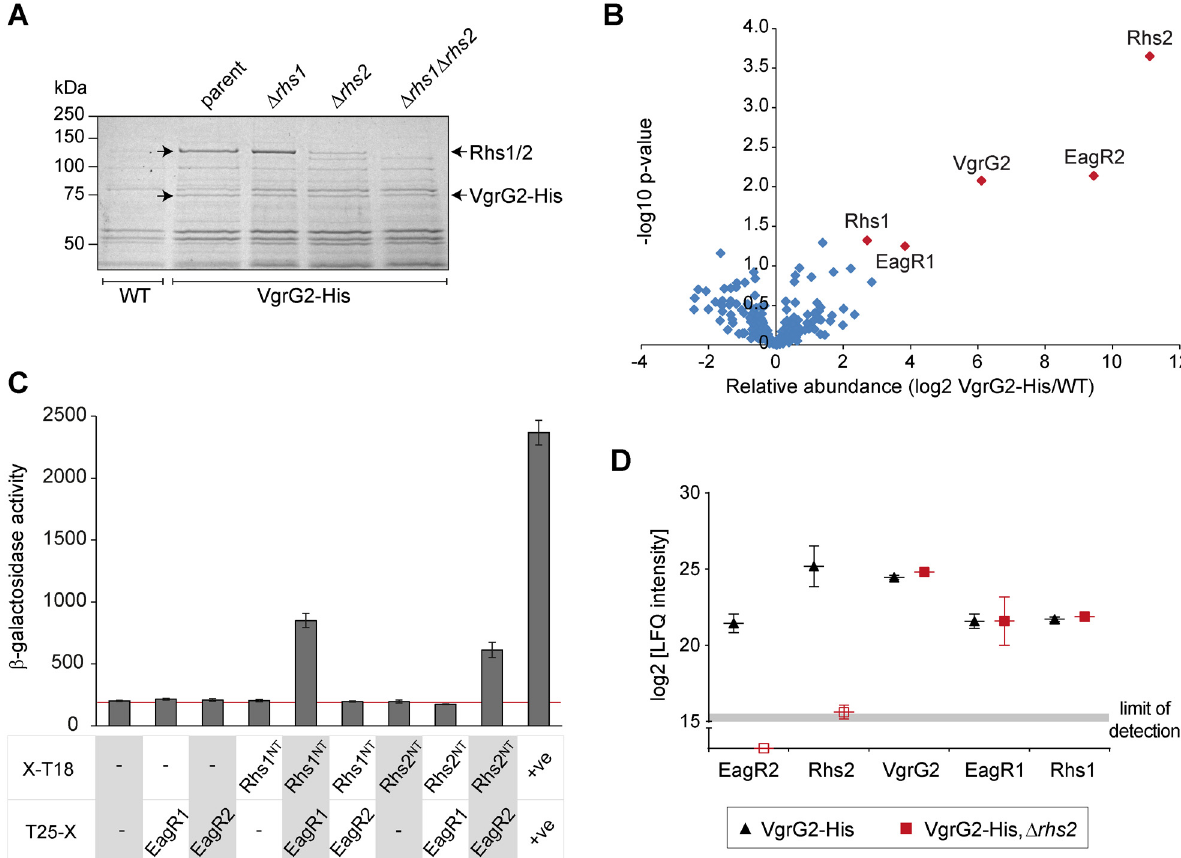
Fig 7. Isolation of native VgrG and PAAR containing complexes. (A) Identification of VgrG2-associated proteins by small-scale affinity purification. Total cellular proteins from S . marcescens Db10 encoding the VgrG2-His 6 fusion protein, in an otherwise wild type genetic background (parental) or in strains lacking Rhs1 ( Δ rhs1 ) or Rhs2 ( Δ rhs2 ) or both Rhs proteins ( Δ rhs1 Δ rhs2 ), or from the wild type (WT, no His 6 tag) as a negative control, were incubated with Ni 2+ beads to co-isolate VgrG2-His 6 (VgrG2-His) with any bound proteins. Eluted proteins were resolved by SDS-PAGE and visualised by Coomassie staining. Arrows indicate the positions of two VgrG2-His specific bands, one corresponding to VgrG2-His (predicted MW 72 kDa) and one corresponding to a mixture, in the parental strain, of Rhs1 and Rhs2 (predicted MW 165 and 158 kDa, respectively); identifications were confirmed by mass spectrometry. (B) Quantitative analysis of the proteins present in samples isolated as above by affinity purification from the control strain (WT) or the strain carrying the VgrG2-His fusion (in an otherwise wild type background) by solution mass spectrometry. Proteins were identified as being associated with VgrG2 when significantly enriched in the VgrG2-His sample compared with the WT sample, with relative abundance in VgrG2-His/WT > 4-fold, p < 0.05 (red diamonds) (C) Bacterial two-hybrid assay to detect interactions between the N-terminal domain of Rhs1 or Rhs2, each fused with T18 (Rhs1 NT -T18, pSC699, and Rhs2 NT -T18, pSC700), and full-length EagR1 or EagR2, each fused with T25 (T25-EagR1, pSC688, and T25-EagR2, pSC689). Negative controls were provided by the empty vectors, pUT18 and pT25 (-), and a positive control by the self-interaction of TssK (+ve; TssK-T18, pSC048, and T25-TssK, pSC053). Shown is β -galactosidase activity, expressed as Δ 405/ min/ml/OD 600 , of the reporter strain transformed with the combinations of plasmids indicated. Bars show mean +/- SEM (n = 3 independent transformations) and the background level of activity is indicated by a red line. (D) As for part B, except that the VgrG2-His affinity purification was performed in the parental and Δ rhs2 backgrounds. The abundance of each of the VgrG2-associated proteins identified in part B in the two strains is given (represented as the log2 of the label-free quantitation intensities), with the effective limit of detection indicated and points showing mean +/- SD (n =